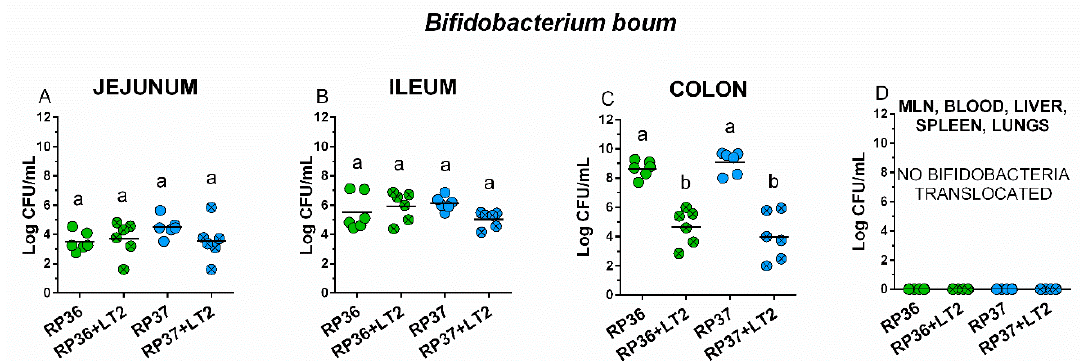
Figure 2. Colonization of the intestine of the gnotobiotic piglets with B. boum strains RP36 and RP37. B. boum strains RP36 and RP37 colony forming units (CFU) were counted in the jejunum ( A ), ileum ( B ), colon ( C ), mesenteric lymph nodes (MLN), blood, liver, spleen, and lungs (all ( D )) in the B. boum monocolonized piglets (RP36 and RP37) and B. boum monocolonized piglets infected with S . Typhimurium (RP36 + LT2 and RP37 + LT2). Interferences between both B. boum strains (RP36 and RP37) and S . Typhimurium (RP36 + LT2 and RP37 + LT2) were evaluated by one-way ANOVA with Tuckey’s multiple comparisons post-hoc test. Statistical di ff erences were marked by a letter system at p < 0.05. The same letter means no statistical significance. Log CFU are depicted as individual spots with mean as a horizontal line and n = 6 for all groups.